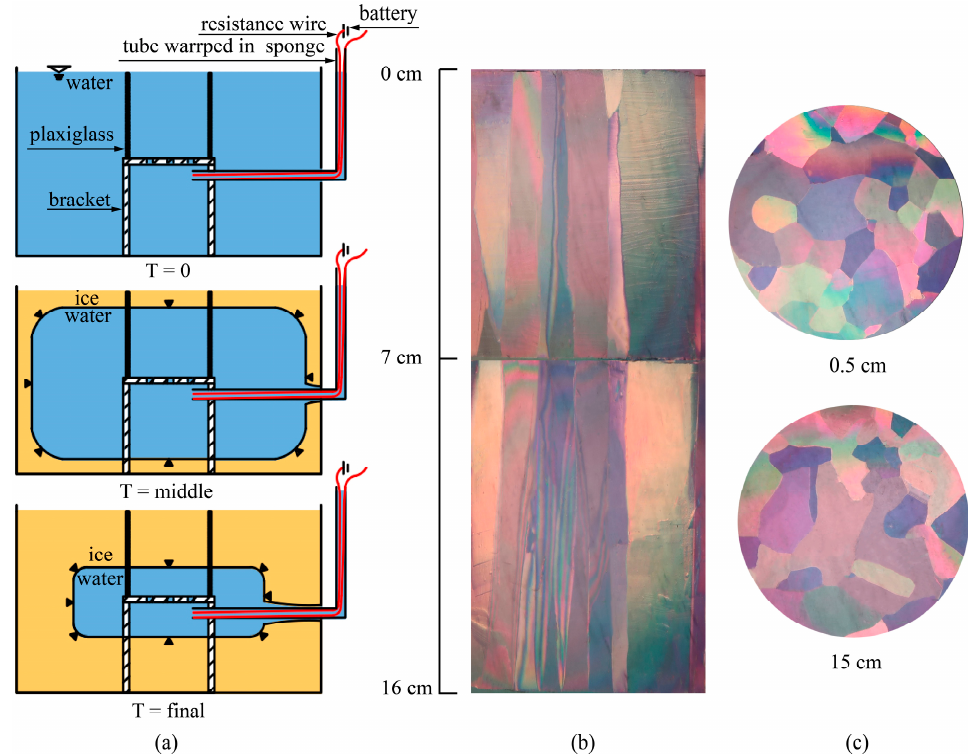
Figure 1. Experiment of unidirectional freezing in a low-temperature indoor laboratory: ( a ) the unidirectional freezing device; ( b ) ice crystal microstructure parallel to the direction of ice growth; ( c ) ice crystal microstructure perpendicular to the direction of ice growth at 0.5 and 15cm.